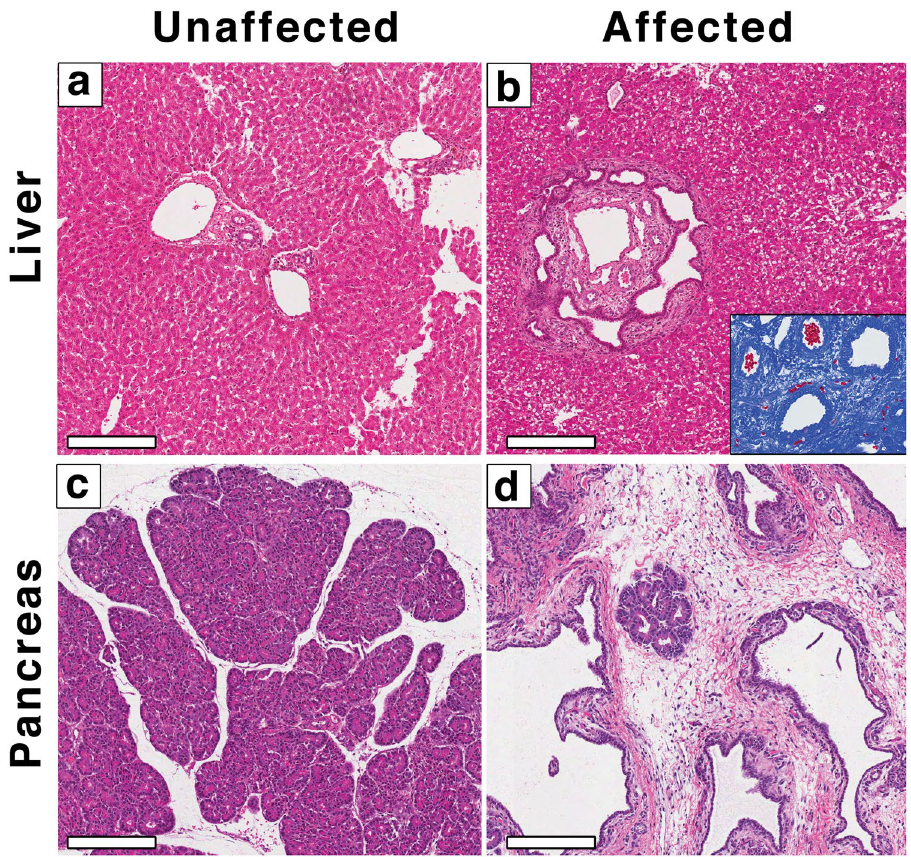
Figure 2. Hepatic and pancreatic abnormalities in affected lambs. ( a , b ) H&E stained tissue sections from an unaffected newborn lamb liver ( a ), showing the portal triad, and an affected newborn lamb liver ( b ), showing the ductal plate malformation in the liver of the affected lamb. ( b -inset) Masson’s Trichrome stained section showing extensive fibrosis. ( c , d ) H&E stained tissue sections from an unaffected ( c ), and an affected ( d ) newborn lamb pancreas, showing extensive fibrosis surrounding an island of pancreatic tissue in the affected lamb. Scale bars = 200 μ